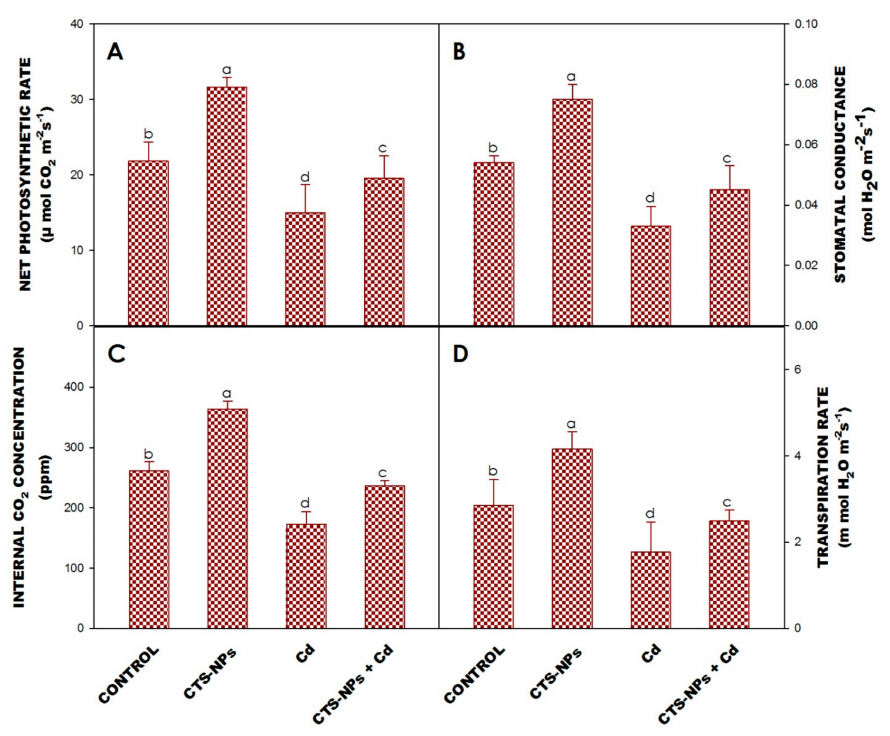
Figure 2. Effect of foliar application of chitosan nanoparticles (CTS-NPs) on net photosynthetic rate ( A ), stomatal conductance ( B ), internal CO 2 concentration ( C ) and transpiration rate ( D ) in cadmium (Cd) stress Solanum lycopersicum at 30 days after sowing. Values are the mean of five replicates with standard errors. Different bar letters show significant differences among treatments